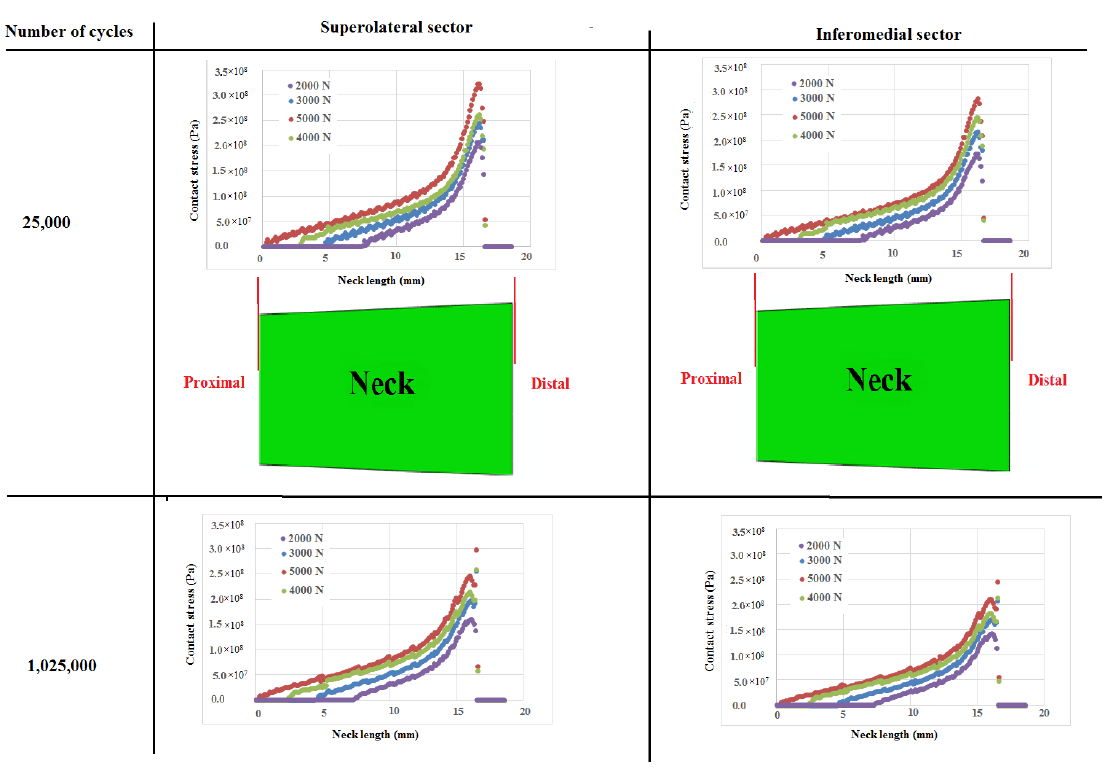
Figure 4. Variation of normal contact stress over the neck length in both super-lateral and infero-medial sectors under different assembly forces and after 25,000 and 1,025,000 loading cycles.